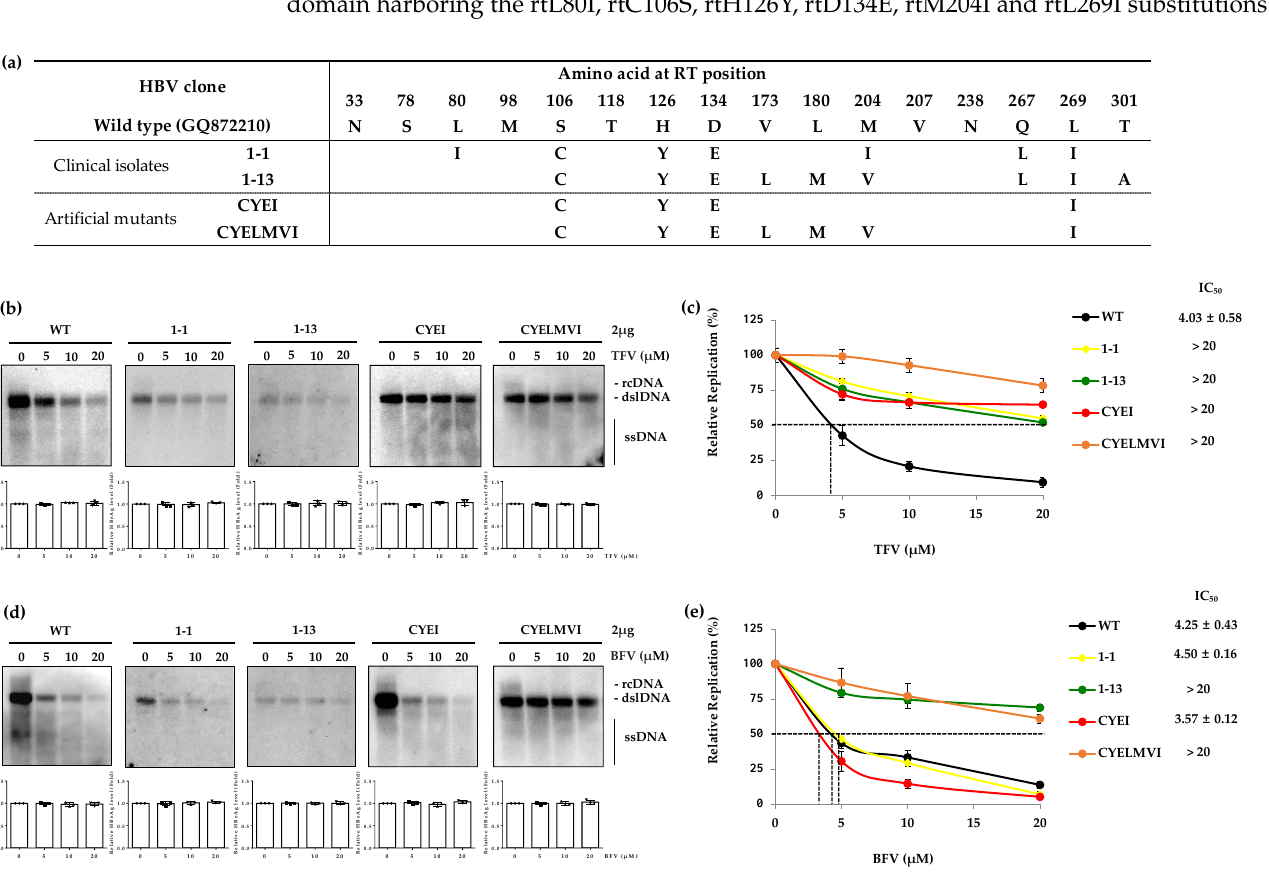
Figure 4. In vitro susceptibility of TFV-resistant HBV clones to BFV. ( a ) The sequence information of patient-derived or artificial HBV mutant clones which are resistant to TFV. ( b , top panels) The patient-derived clones or artificial mutants were transfected into the Huh7 cells. TFV was then administered for 4 days at the indicated concentrations. The level of HBV replication was analyzed by Southern blot. ( c ) The IC 50 value for TFV-resistant clones and WT were compared. ( d , top panels) The drug susceptibility for BFV were determined by Southern blot analysis. ( e ) The IC 50 values of clinical isolates or artificial constructs were compared with WT. ( b , d , bottom panels) The transfection yield was confirmed by measuring the level of HBeAg in the culture supernatant using ELISA. The data were obtained from at least three independent experiments (mean ± SD). BFV, besifovir; TFV,